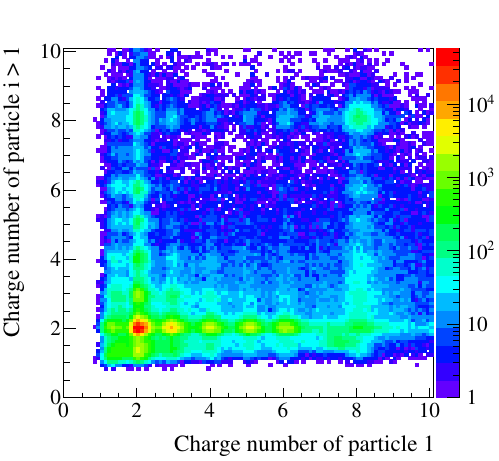
Figure 3. Charge number of first particle measured by ToFD in one event vs. charge number of every other particle in this event.